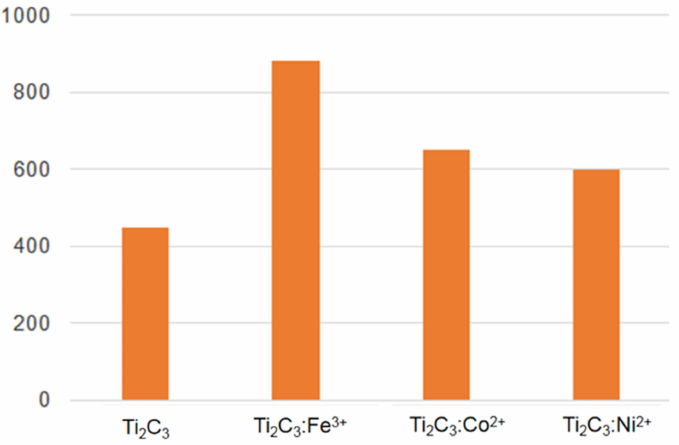
Figure 7. The electrical conductivity of Ti 3 C 2 , Ti 3 C 2 /Fe 3+ /Co 2+ /Ni 2+